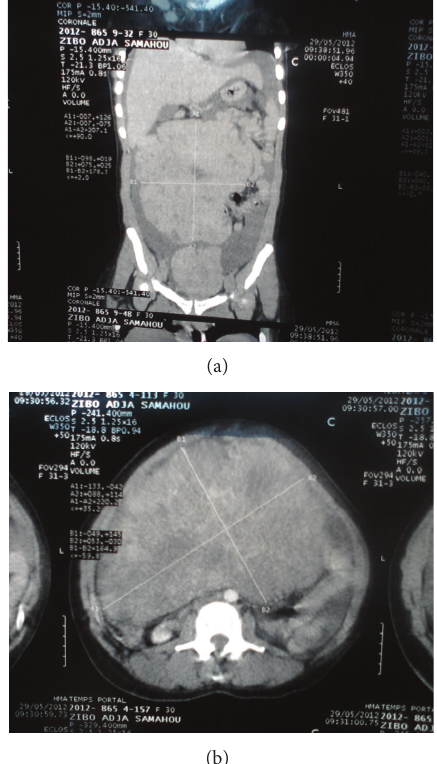
Figure 2: Abdominal CT scan showing two abdominopelvic tissue masses